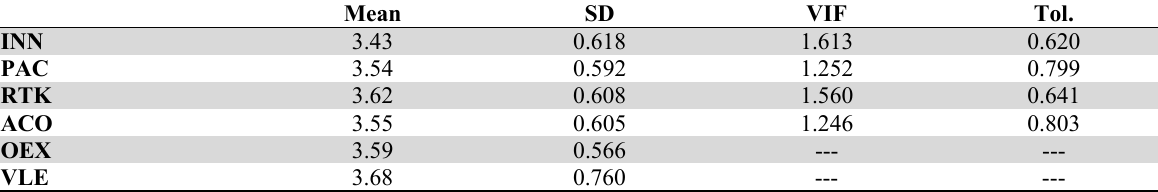
The results of descriptive analysis and